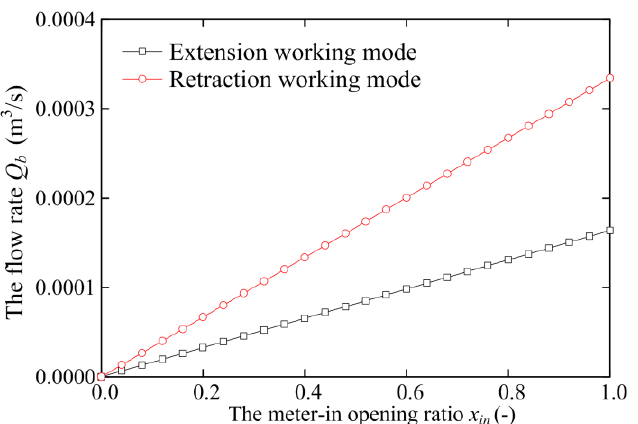
Figure 26. The variations of the flow rate Q b of the cylinder rod chamber of HPCIMS.